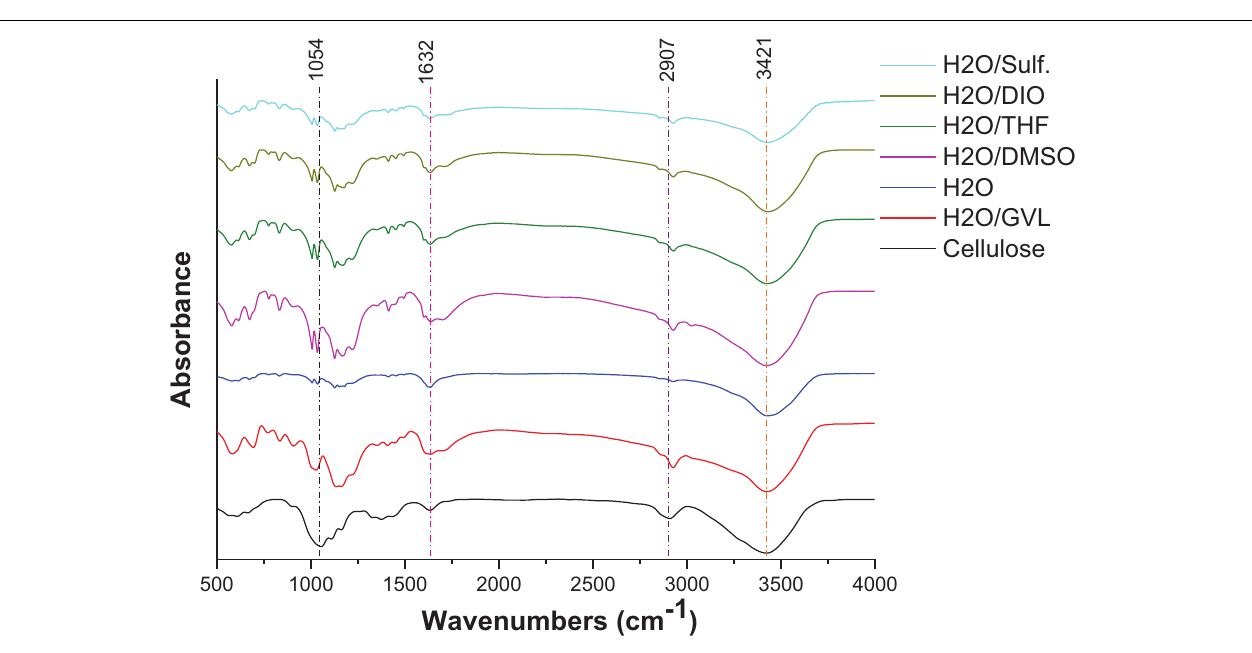
FIGURE 3 | FTIR spectra of cellulose and solid residues after reactions with different biphasic solvent